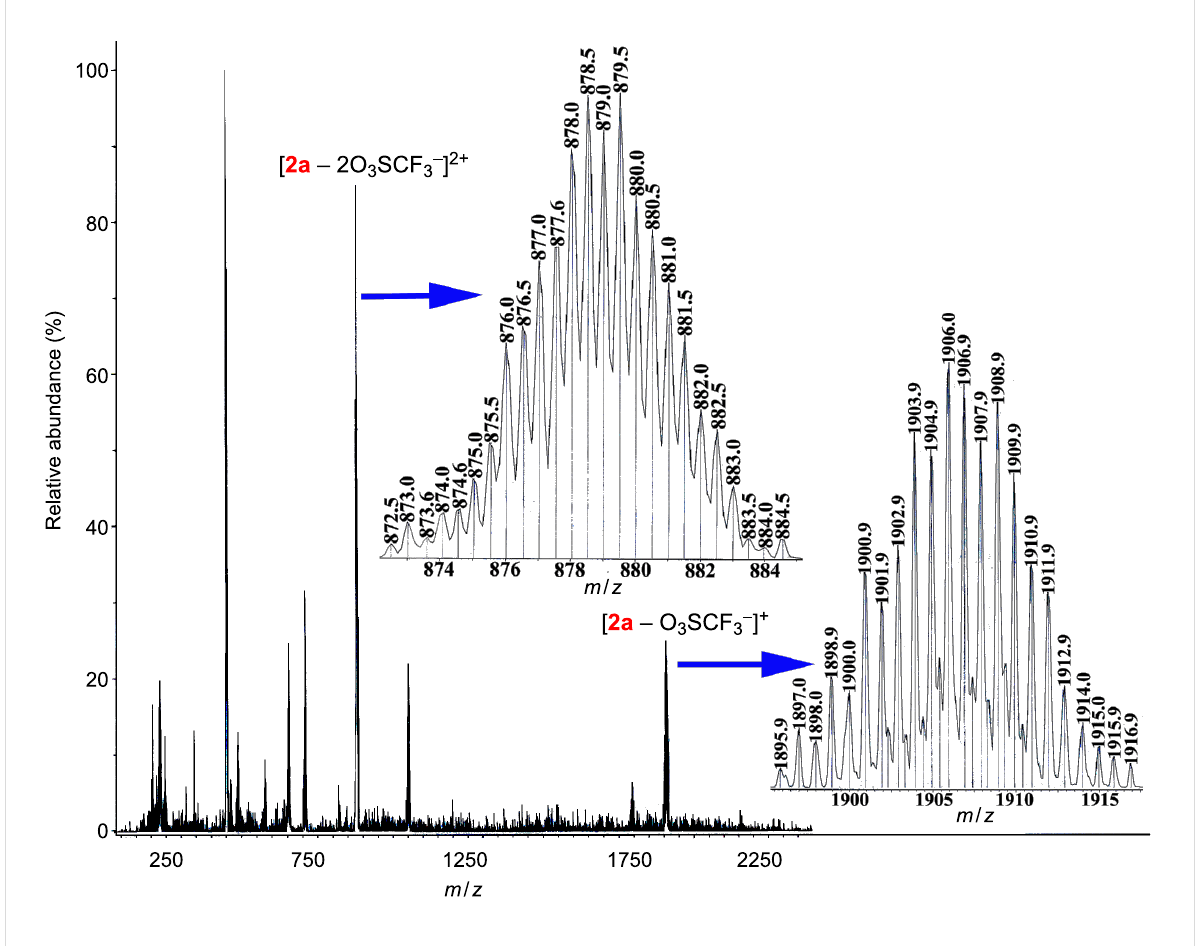
Figure 2: ESIMS spectrum of the macrocycle 2a recorded in acetonitrile. Inset: Experimentally observed isotopic distribution for [ 2a − O 3 SCF 3 − ] + and [ 2a − 2O 3 SCF 3 − ] 2+